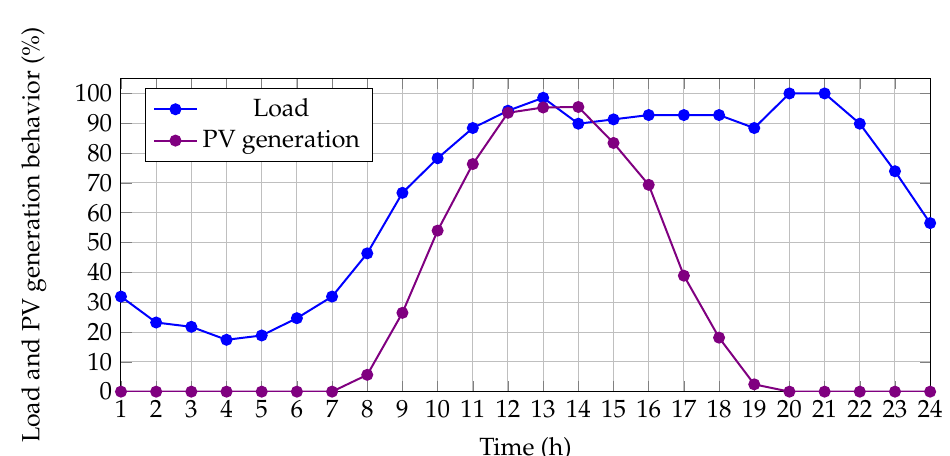
Figure 3. Typical behavior of the generation and demand curves reported for Medellín